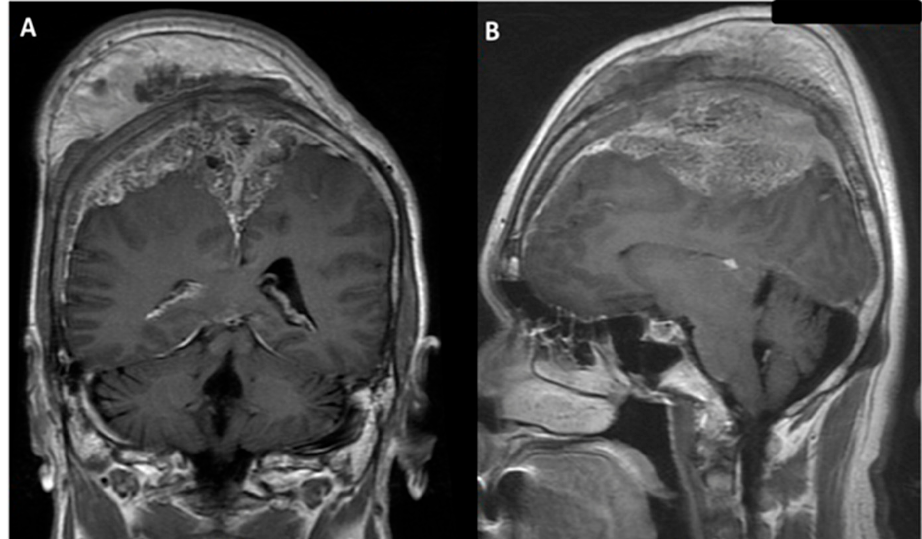
Figure 2. Brain magnetic resonance imaging (MRI) with gadolinium image revealed enhancement of an extra-axial tumor, involving scalp and bilateral frontal bone with encasement of the superior sagittal sinus; parasagittal meningioma was impressed: ( A ) coronal view; ( B ) sagittal view. However, muscle powers of bilateral lower limbs progressed to downhill from grade 4 to 0, and the muscle power of the left upper limb was also progressed to 2 within 24 h after operation. Muscle tone was still preserved. Emergency brain CT demonstrated no hemorrhage, but mild edematous change of right vertex frontal-parietal lobe (Figure 3). Then, brain MRI was performed due to several episodes of intermittent seizure and poor recovery of muscle power post-operation. Brain MRI with T1 contrast revealed gross total removal of the meningioma without hematoma or obvious residual tumor to compress the surface of the brain parenchyma (Figure 4A,B). In addition, brain MRI with diffusion- weighted image (DWI) and apparent diffusion coefficient (ADC) revealed no obvious cortical damage in the SMA territory, nerve tract injury or acute infarction were found (Figure 5A,B). Mutism was also noted 2 days after the operation. Due to clinical presentations and image findings, postoperative SMA syndrome was diagnosed. Steroids and mannitol were used for mild brain edematous change. Prophylactic antibiotics were